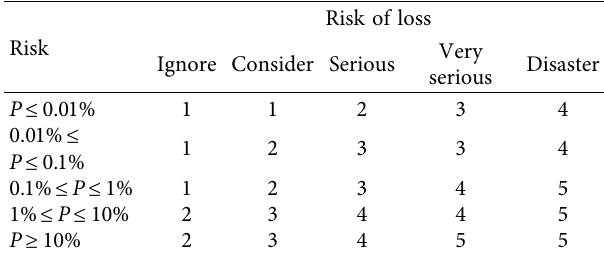
Table 6: Risk evaluation